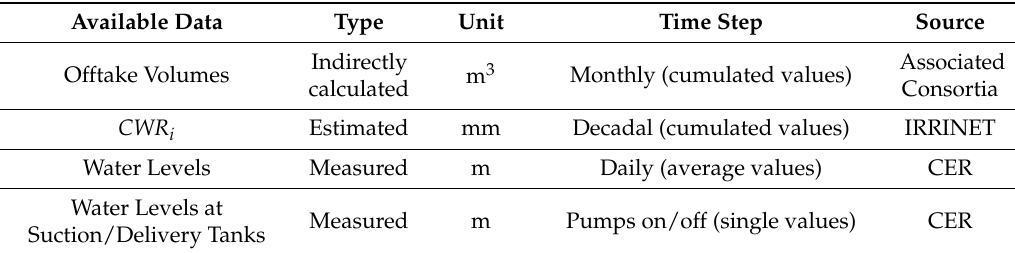
Table 1. The available data and their